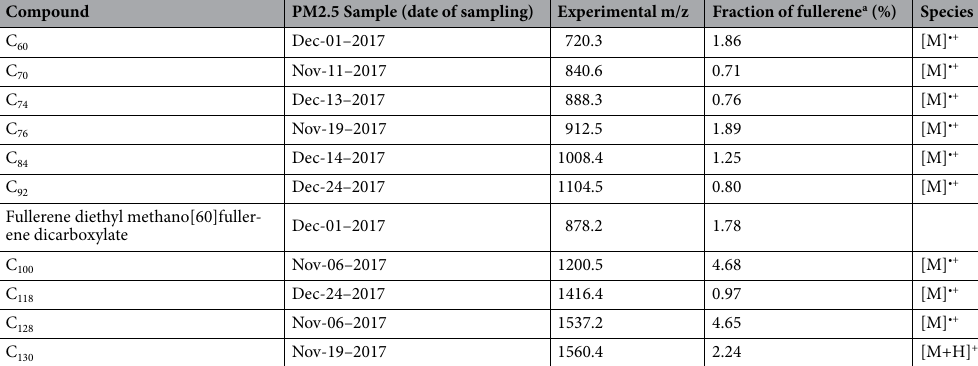
Table 1. Detected fullerenes and their derivatives detected in the MALDI-TOF analyses using CHCA as matrix. a Calculated from fullerenes peak